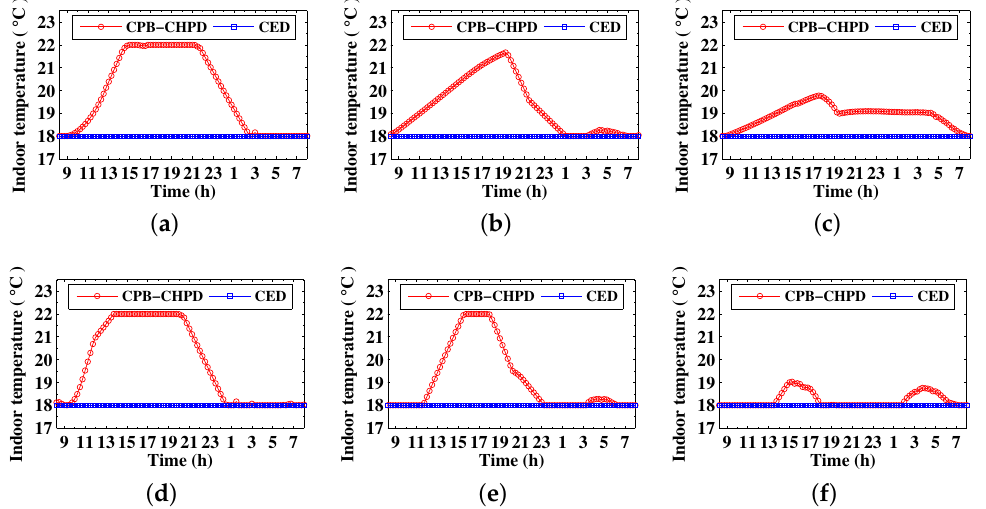
Figure 9. Profiles of indoor temperatures in Case 1 at each period: ( a ) Building1; ( b ) Building2; ( c ) Building3; ( d ) Building4; ( e ) Building5 ; ( f )